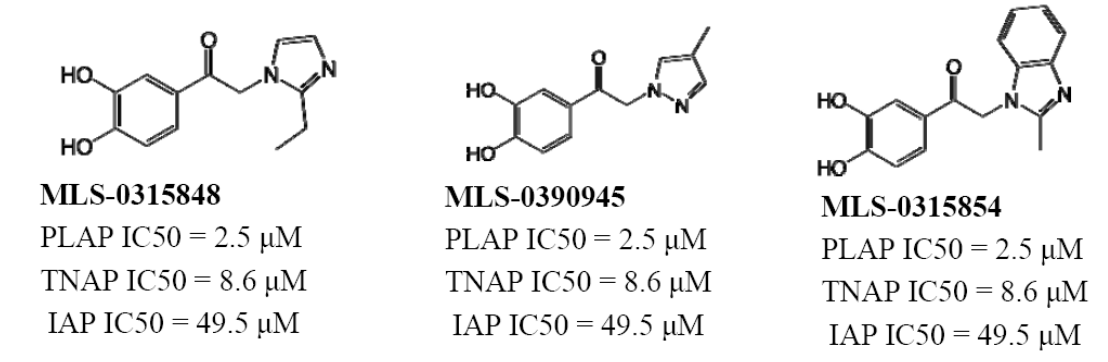
Figure 10. Example of Right Hand Side modifications of MLS-0315687.